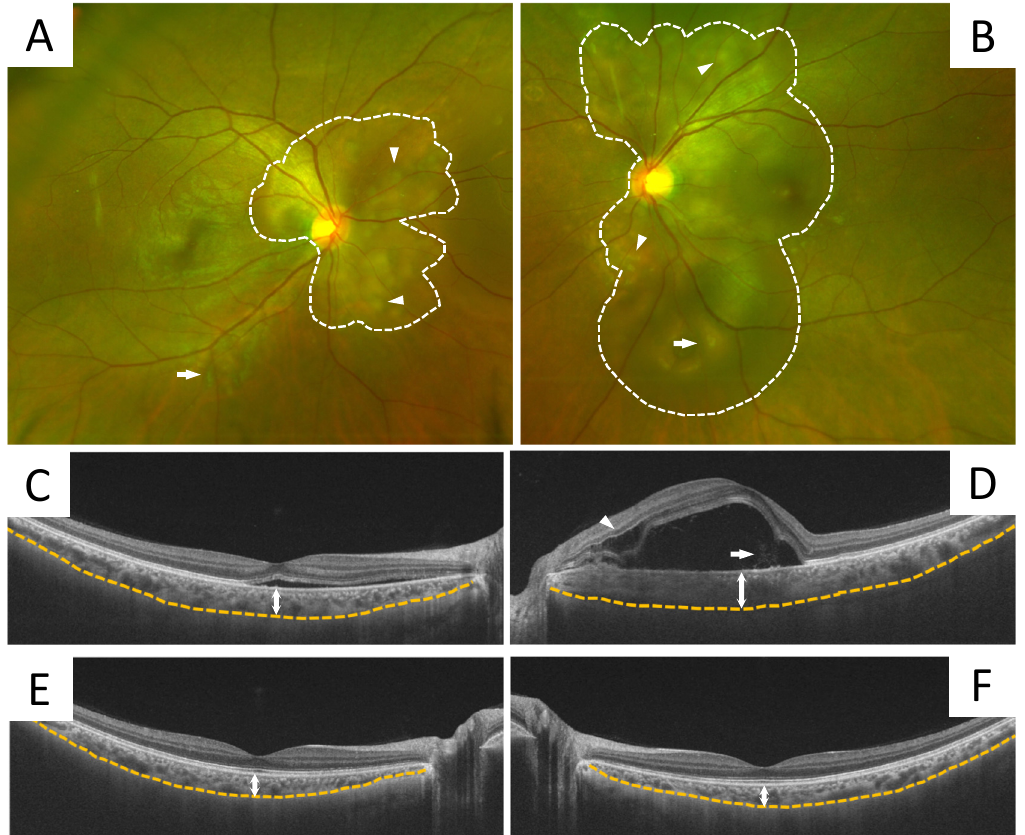
Figure 4. Images showing the findings in a typical case, i.e., a 31-year-old female patient who underwent a scheduled cesarean section at 33 weeks and 2 days and presented at the Department of Ophthalmology complaining of bilateral blurred vision at 1 day post-operative. She had complications of preeclampsia and HELLP syndrome, and was hospitalized in the Department of Obstetrics. Findings of the fundus examination performed at the initial visit revealed SRD (dotted line), Elschnig’s spots (arrowheads), and Siegrist streaks (arrows) around the optic nerve papillae in both eyes ( A , B ). OCT examination at the initial visit showed SRD with intraretinal edema (arrowhead) and septum (arrow), and increased SCT in both eyes (OD: 400 µ m, OS: 455 µ m) ( C , D ). After about 3 weeks, her general condition stabilized and her blood pressure normalized. Then, without ophthalmologic intervention, the SRD disappeared and the SCT decreased (OD: 256 µ m, OS: 240 µ m) ( E , F